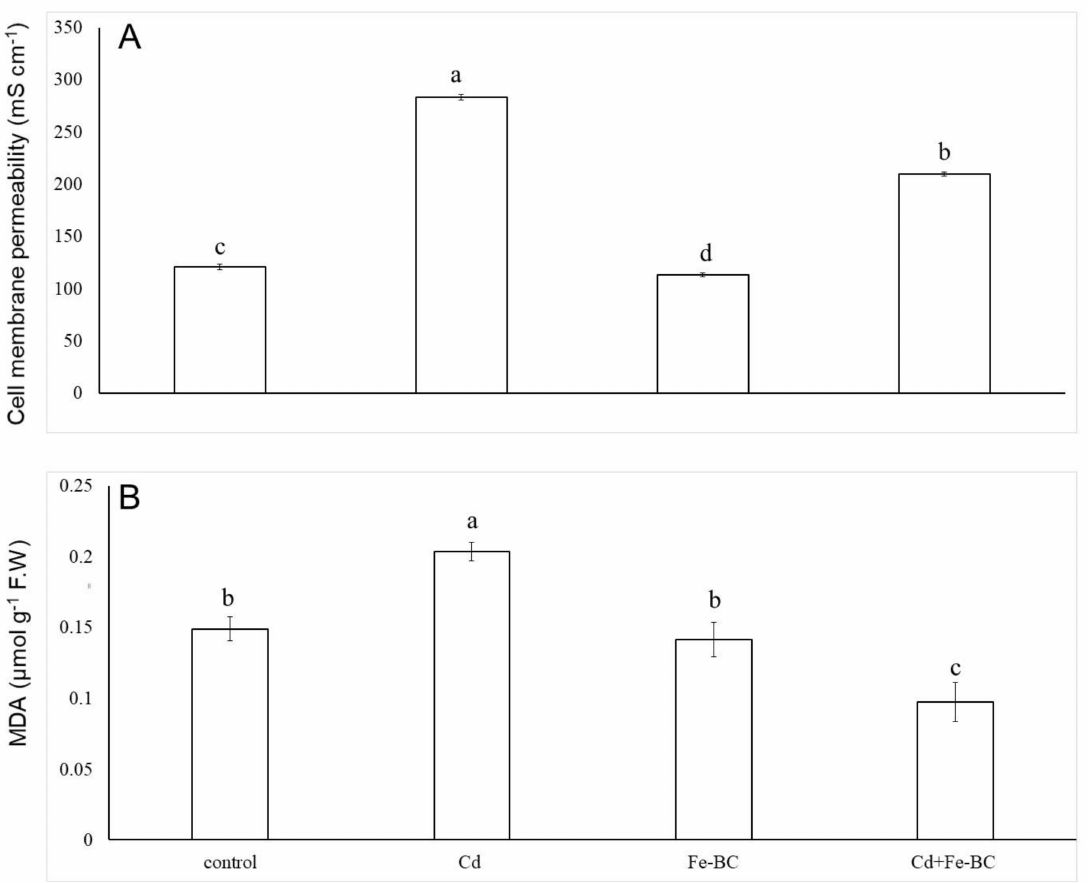
Figure 1. Cell membrane permeability ( A ) (mS cm − 1 ) and malondialdehyde (MDA) ( B ) ( µ mol g − 1 F.W.) concentration of radish cultivar grown under various treatments (control, Cd, Fe-BC, Cd+Fe-BC). There were three repeats/treatment. Values are the average of three replicates ± standard error of mean